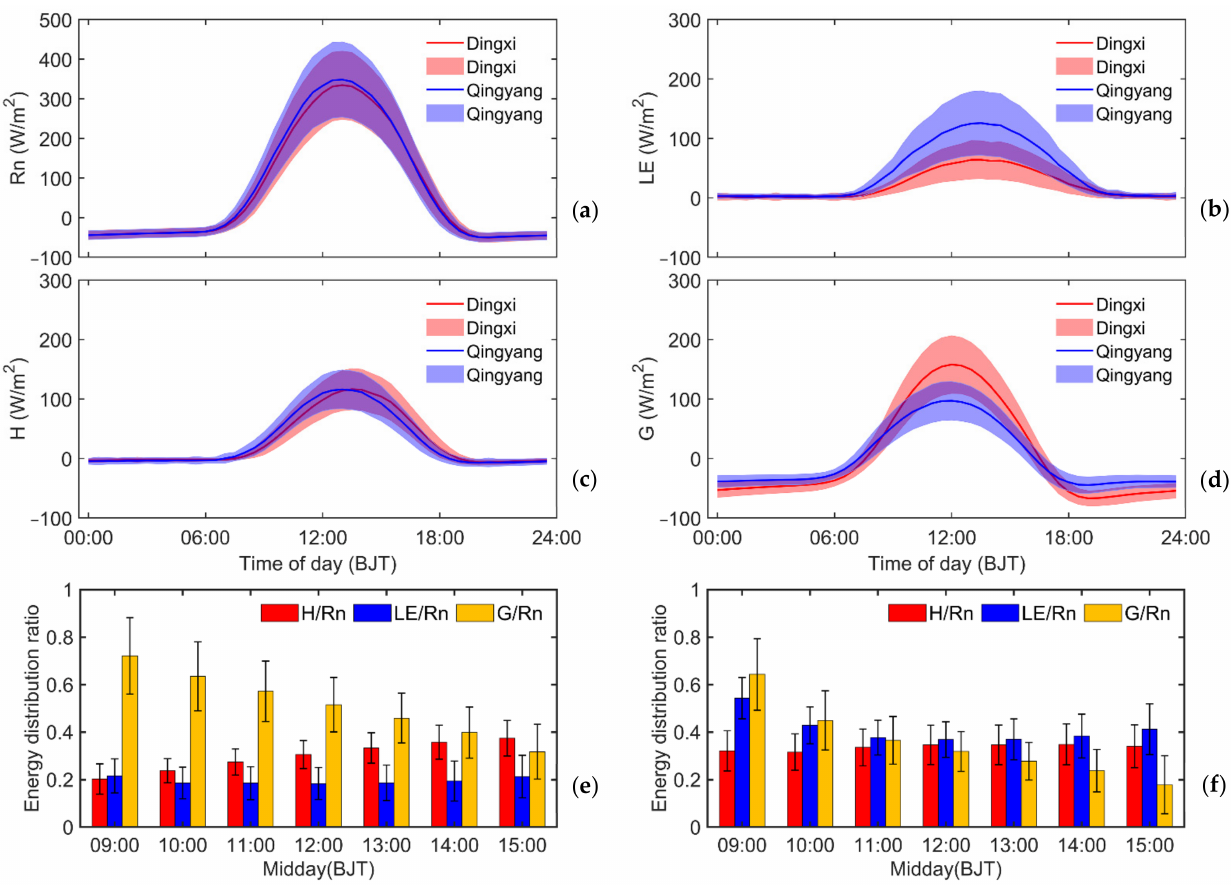
Figure 5. Annual average diurnal variation in energy flux ( a – d ), and the ratio of H , LE , and G to Rn at midday at Dingxi ( e ) and Qingyang ( f ). Rn is net radiation, H is the sensible heat flux, LE is the latent heat flux, and G is the soil heat